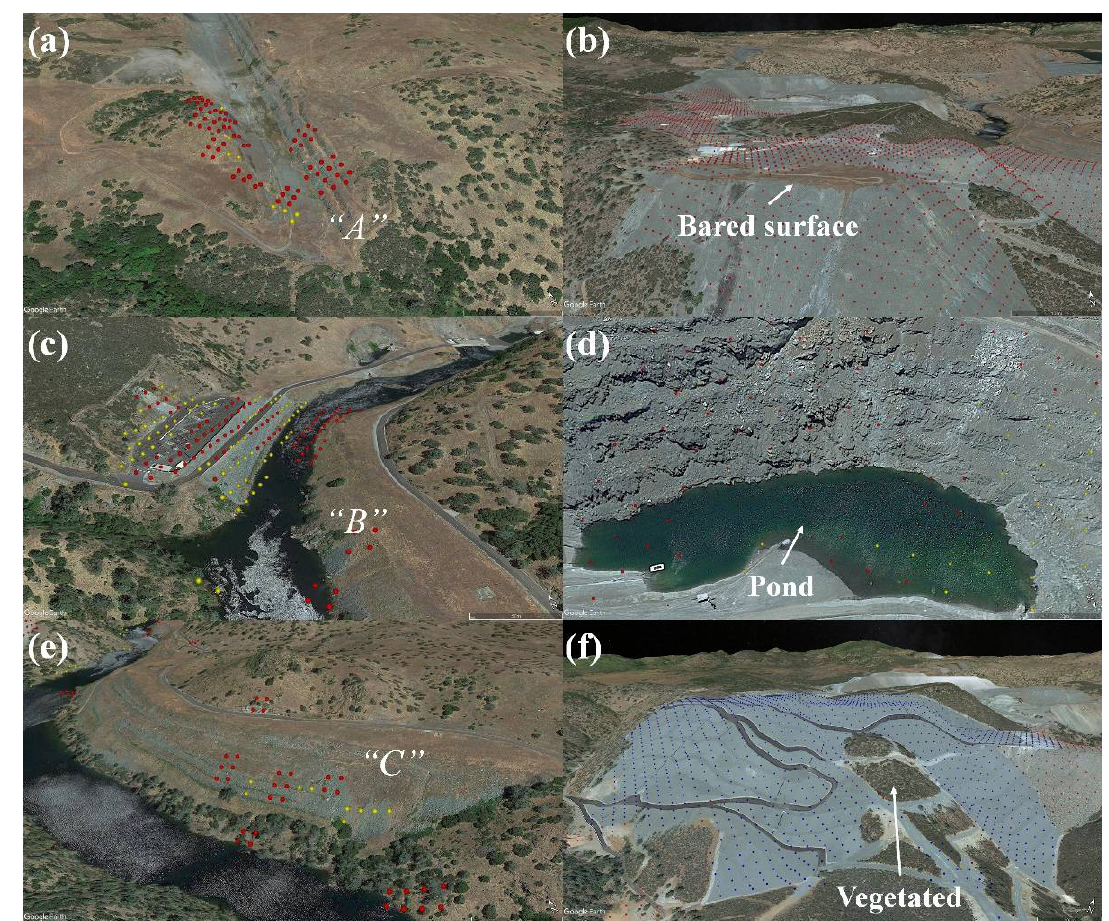
Figure 8. Additional high-resolution satellite image-based 3D viewings (Google Earth) for marked regions of A , B , and C and arrow locations are in Figure 7. The red, blue, and yellow color classes are NOAI, CAP, and HRI classes. ( a , c , e ) Represent class distributions near outcropped rock surfaces. ( b , d , f ) Present the representative areas that are not class-assigned by the model applications. Backgrounded satellite images represent June 2013 and May 2018 for ( b ) and ( a , c – f ), respectively.